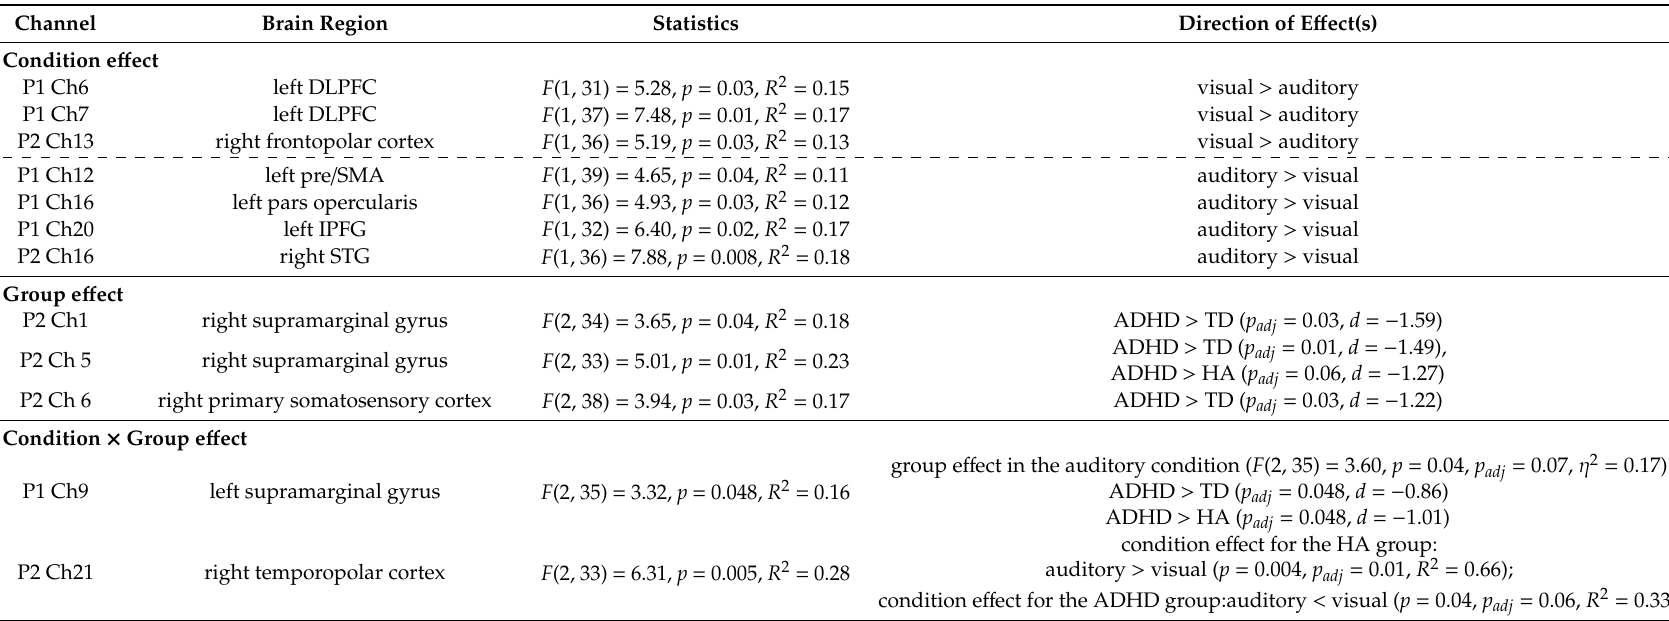
Table 3. E ff ects of group and condition on ∆